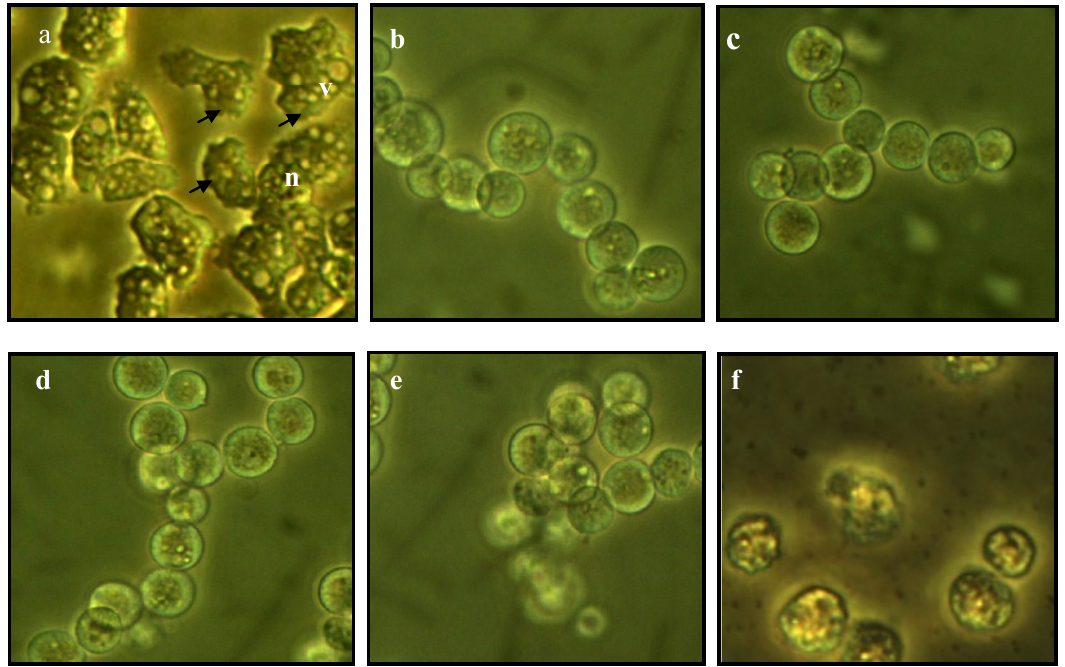
Figure 1. Light microscopy of A. castellanii ( a ) Untreated cells with obvious acanthapodia structures on the cells surface (arrows); ( b ) M1- treated cells; ( c ) M2- treated cells; ( d ) M3- treated cells; ( e ) M4- treated cells; ( f ) Chlorhexidine-treated cells. Nucleus ( n ); vacuoles ( v ). Magnification